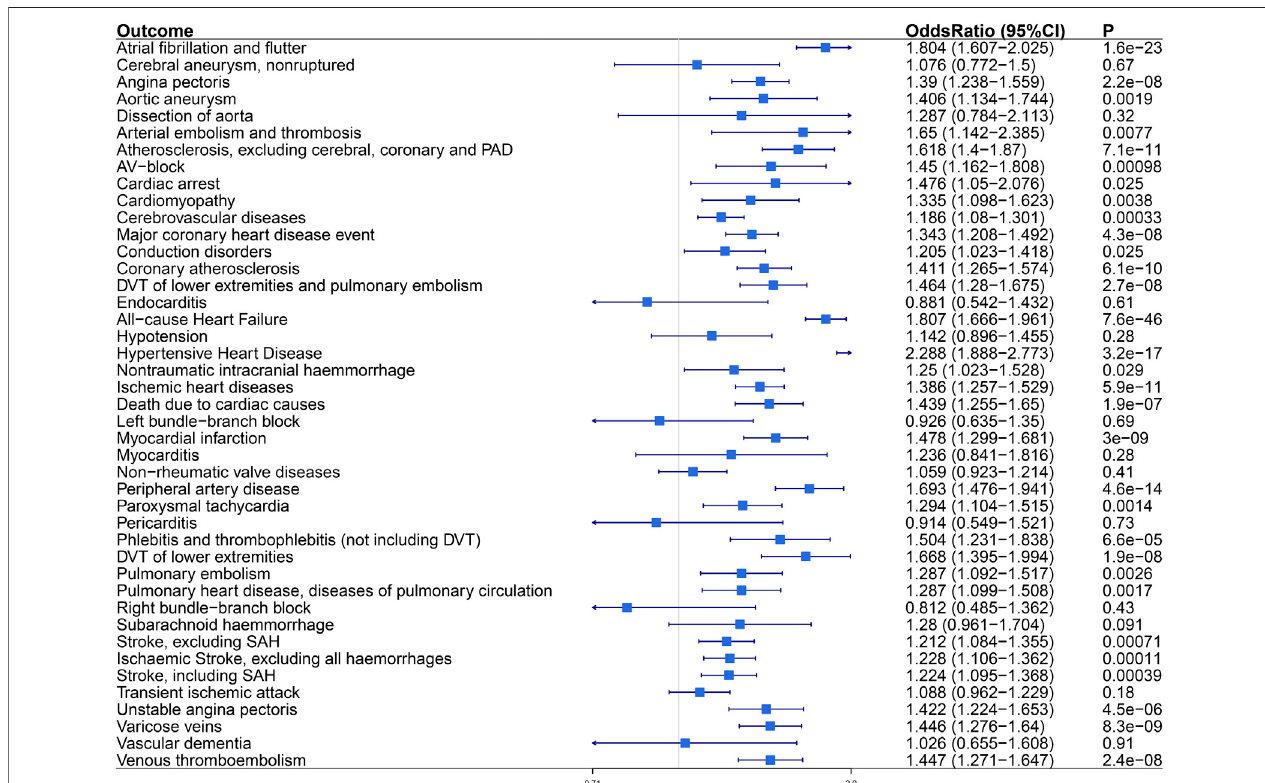
FIGURE 3 | The causal effect of visceral adiposity on 43 CVD endpoints from the FinnGen analysis. Odds ratios are expressed per 1-SD increase in genetically determined VAT mass. CI, con fi dence interval; PAD, peripheral arterial disease; AV-block, atrioventricular block; DVT, deep vein thrombosis; SAH, subarachnoid